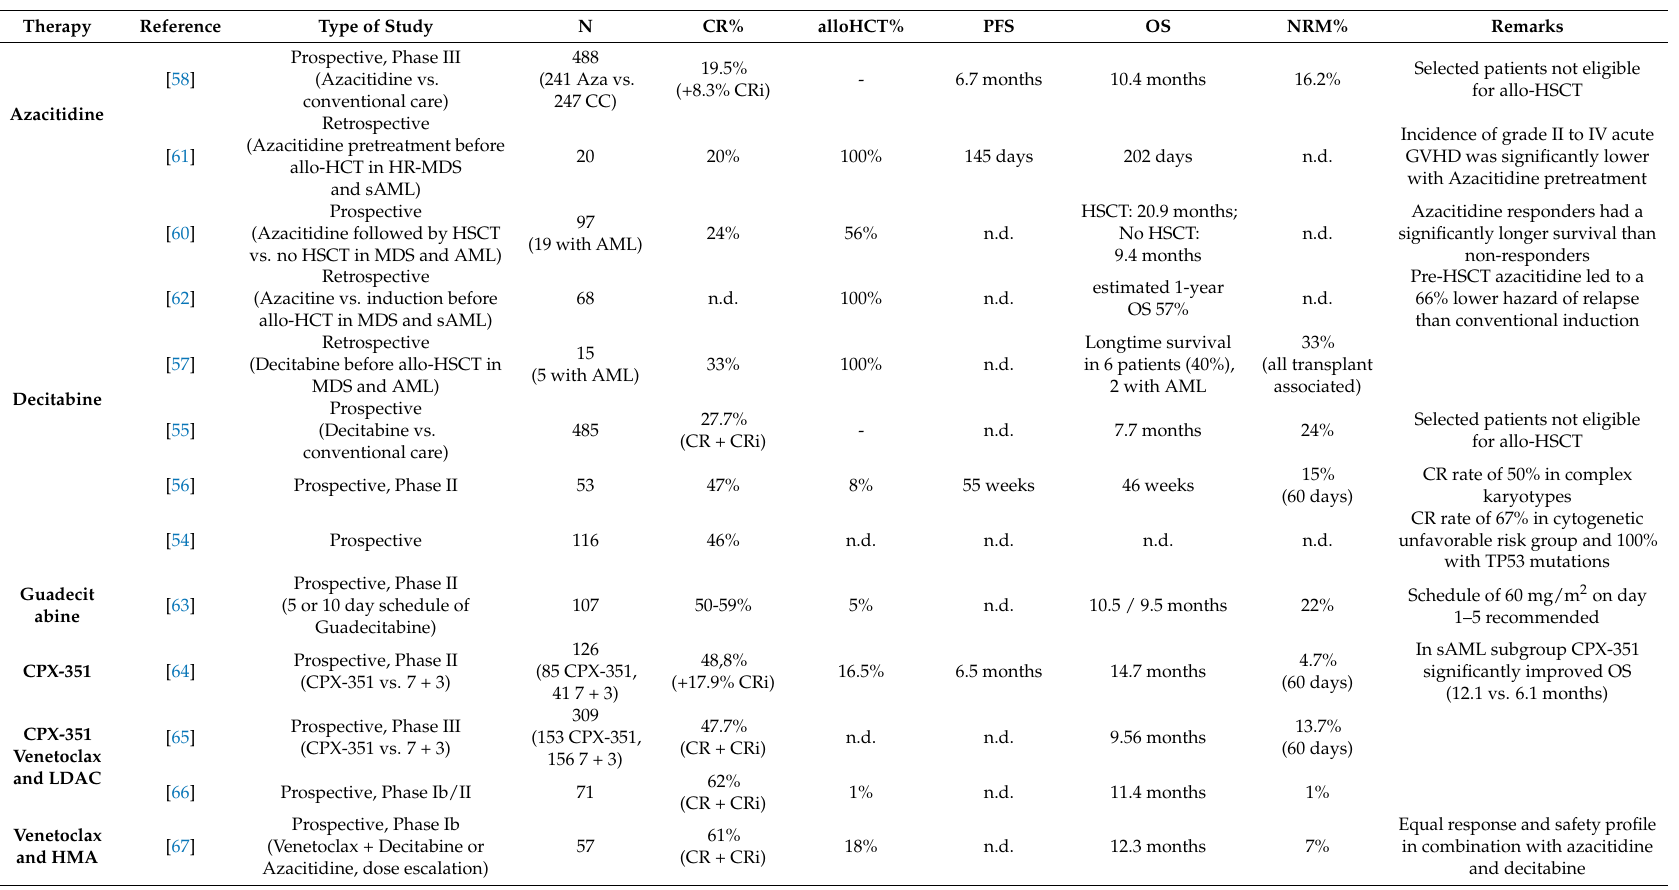
Table 2. Selected novel bridging to transplant strategies for elderly AML